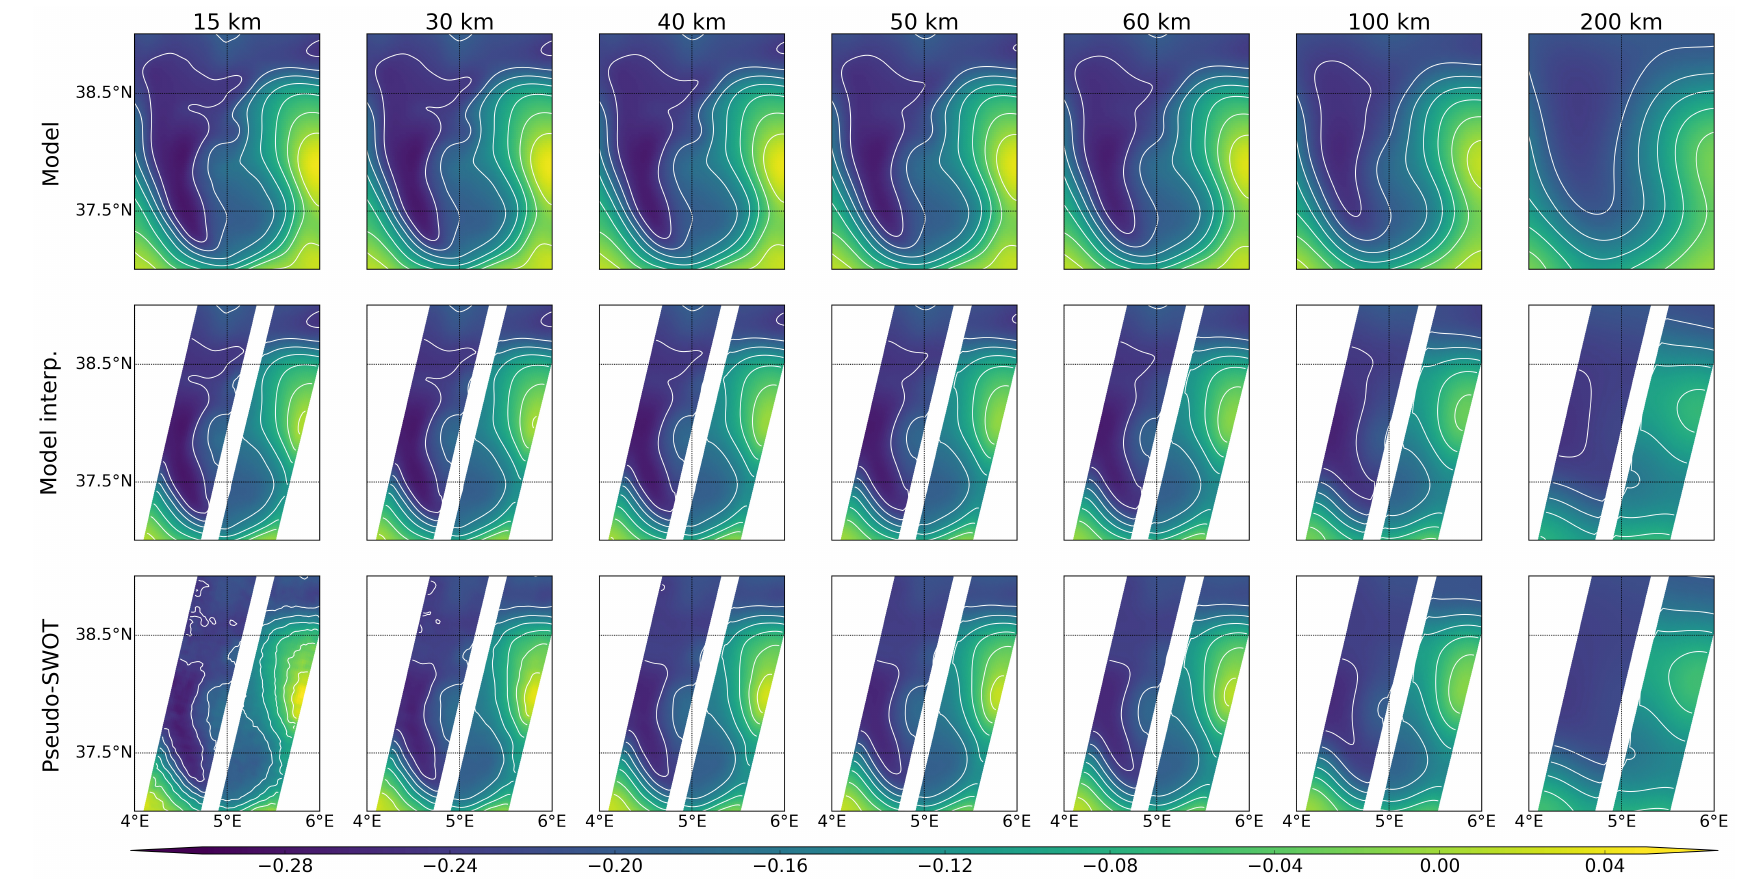
Figure 7. SSH (m) on 23 January 2009 corresponding to pass 15 of cycle